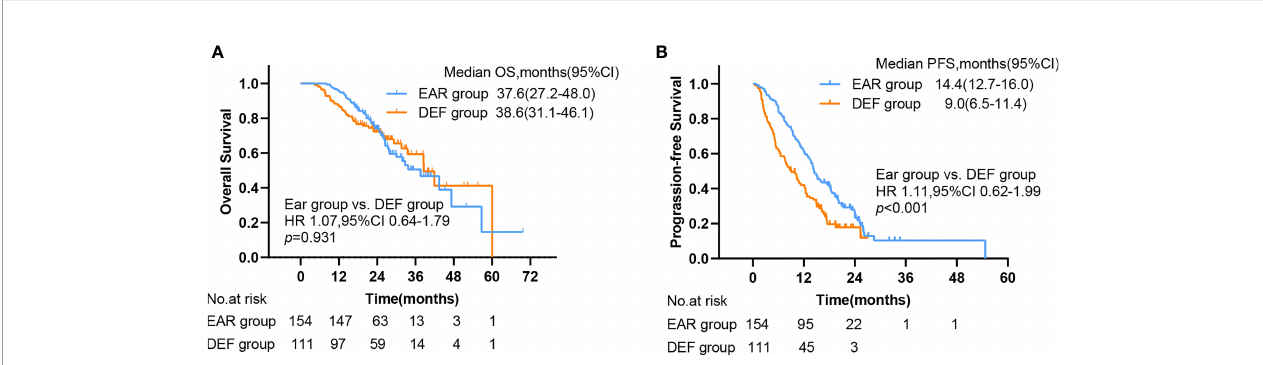
FIGURE 3 | Kaplan – Meier plots of (A) OS and (B) PFS in EAR and DEF, with numbers at risk shown below the graph. PFS, progression-free survival; OS, overall survival; CI, con fi dence interval, EAR, early to initiate radiotherapy group ( ≤ 53 days); DEF, deferred radiotherapy group (>53 days).